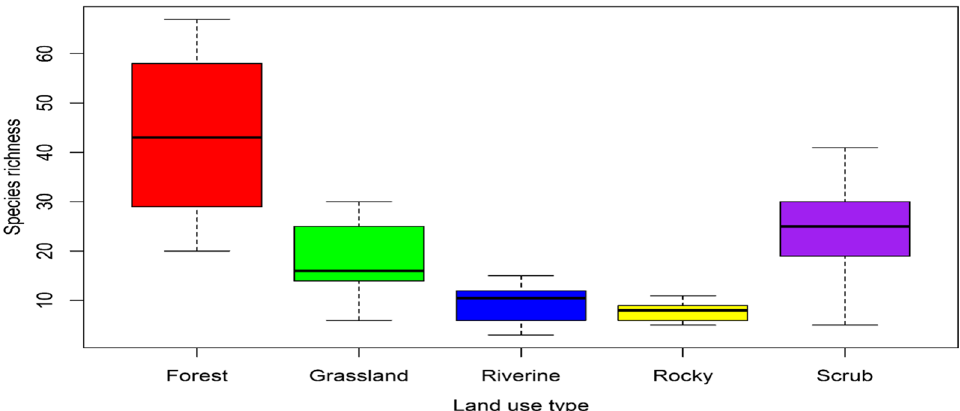
Fig. 5 Boxplot of the observed bird species richness across studied land use types sites during the study